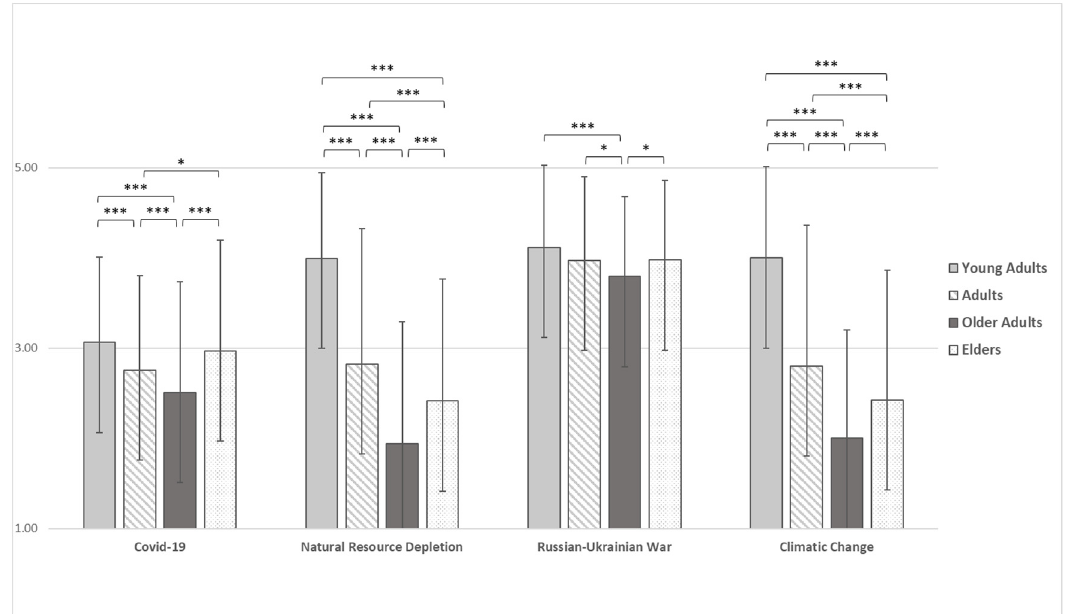
Figure 1. Differences among age groups in COVID-19, Natural Resources Depletion, Russia-Ukraine War, and Climatic Change preoccupation. Note. * = p < 0.05, *** = p < 0.001.